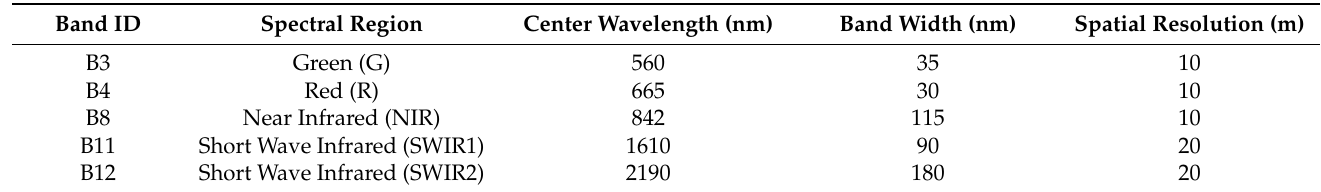
Table 2. Sentinel-2 satellite data spectral bands selected, and imagery spatial